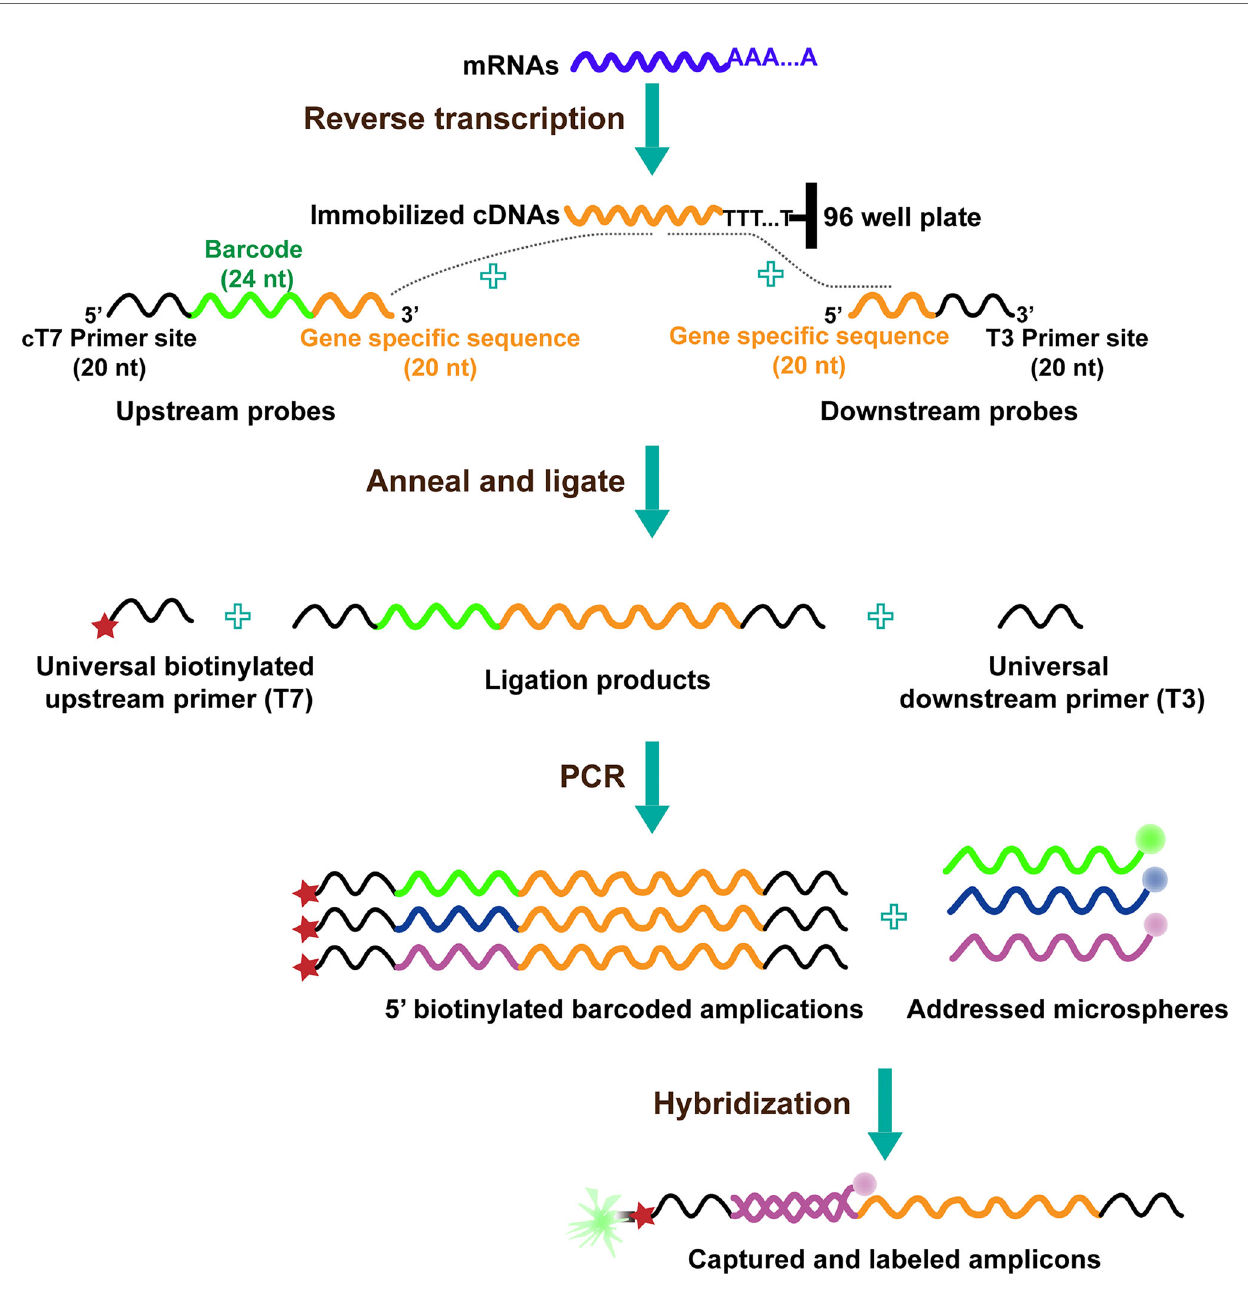
FIGURE 1 | The diagram of L1000 technology